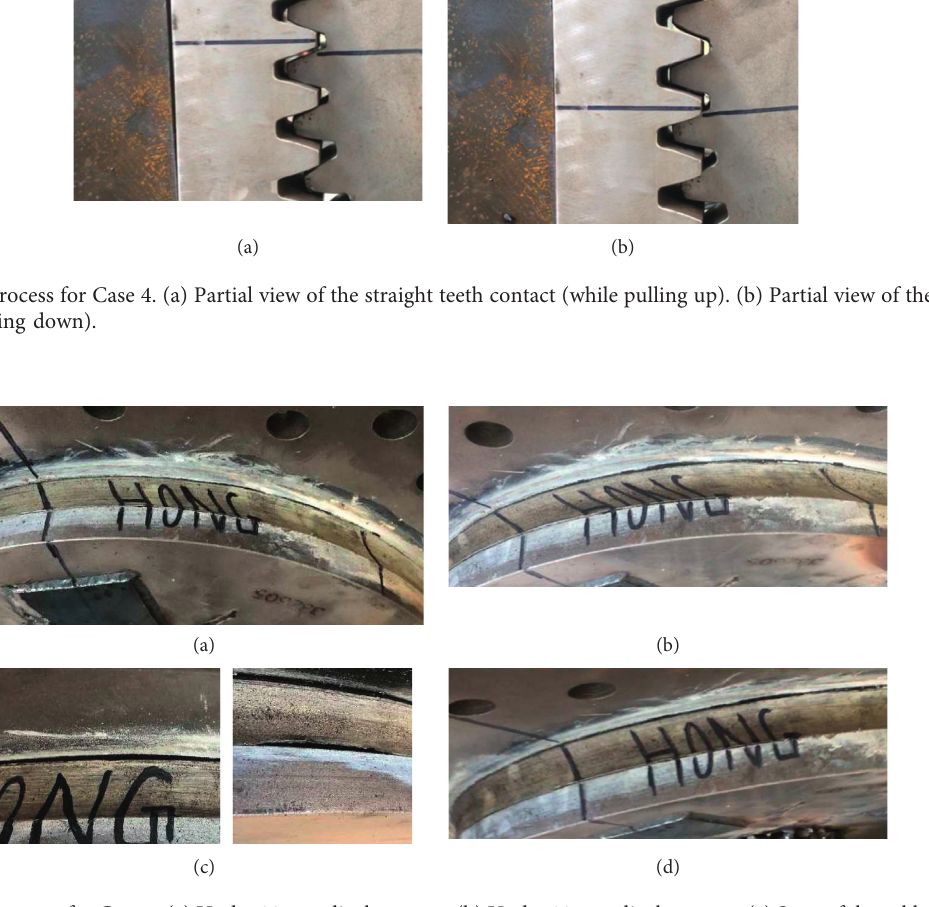
Figure 10: Loading process for Case 5. (a) Under 20mm displacement. (b) Under 30 mm displacement. (c) State of the rubber after testing. (d) Gap between the rubber and the steel